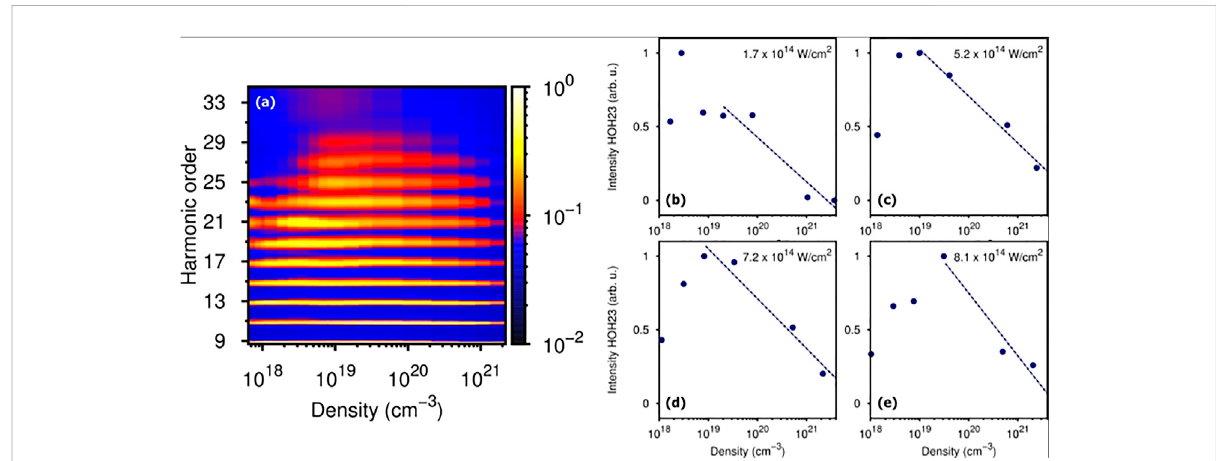
FIGURE 2 (A) Measuredspectraofharmonicradiationasafunctionofthedensityofthetargetatanintensityofthepumppulseof I pump =7.2×10 14 W/cm 2 andanintensityoftheprobepulseof I probe =9.5×10 14 W/cm 2 . (B) to (E) outlinesthesignalofthe23rdharmonicorderwithdifferentintensitiesofthe pump pulse. The dashed lines indicate the linear fi t to the high-density regime. The slopes of the fi ts decrease from (B) − 0.131 via (C) − 0.138 and (D) − 0.147 to (E) − 0.185.